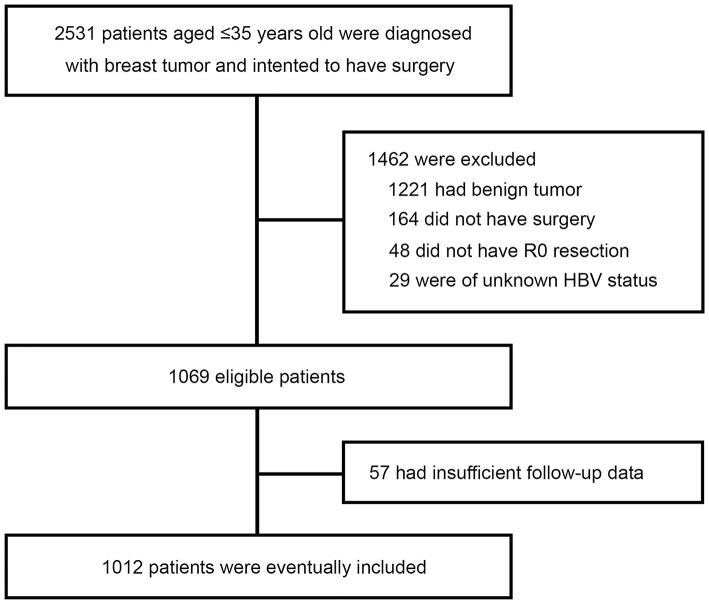
The process of patient selection.